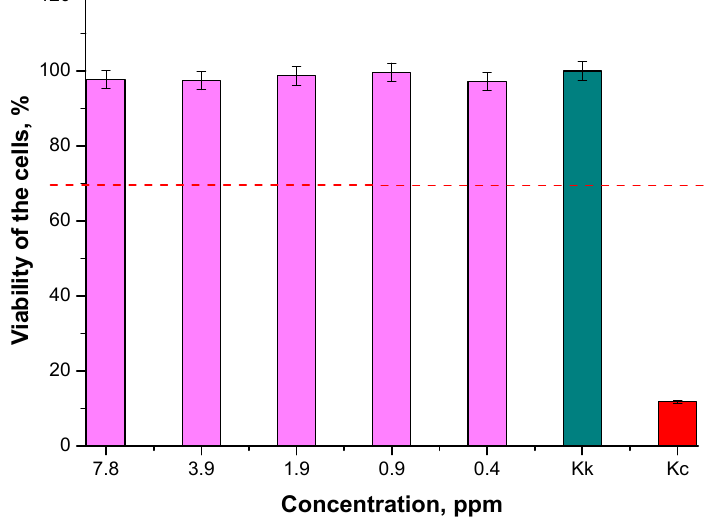
Figure 14. Results of MTT reduction assay of Fe 3 O 4 @Au nanoparticle suspensions prepared in the oil and water environment (the cell viability over 70%—this has been marked via a red dotted line—indicates non-cytotoxicity of tested materials).